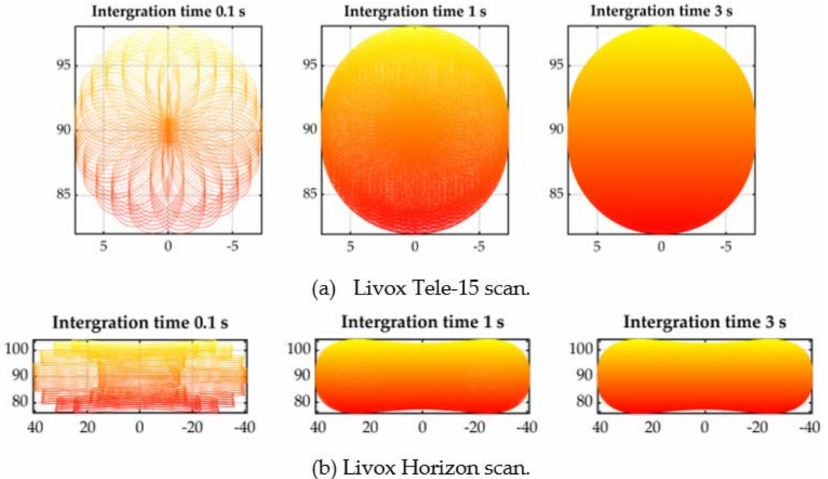
Figure 4. Visual illustration of the two different